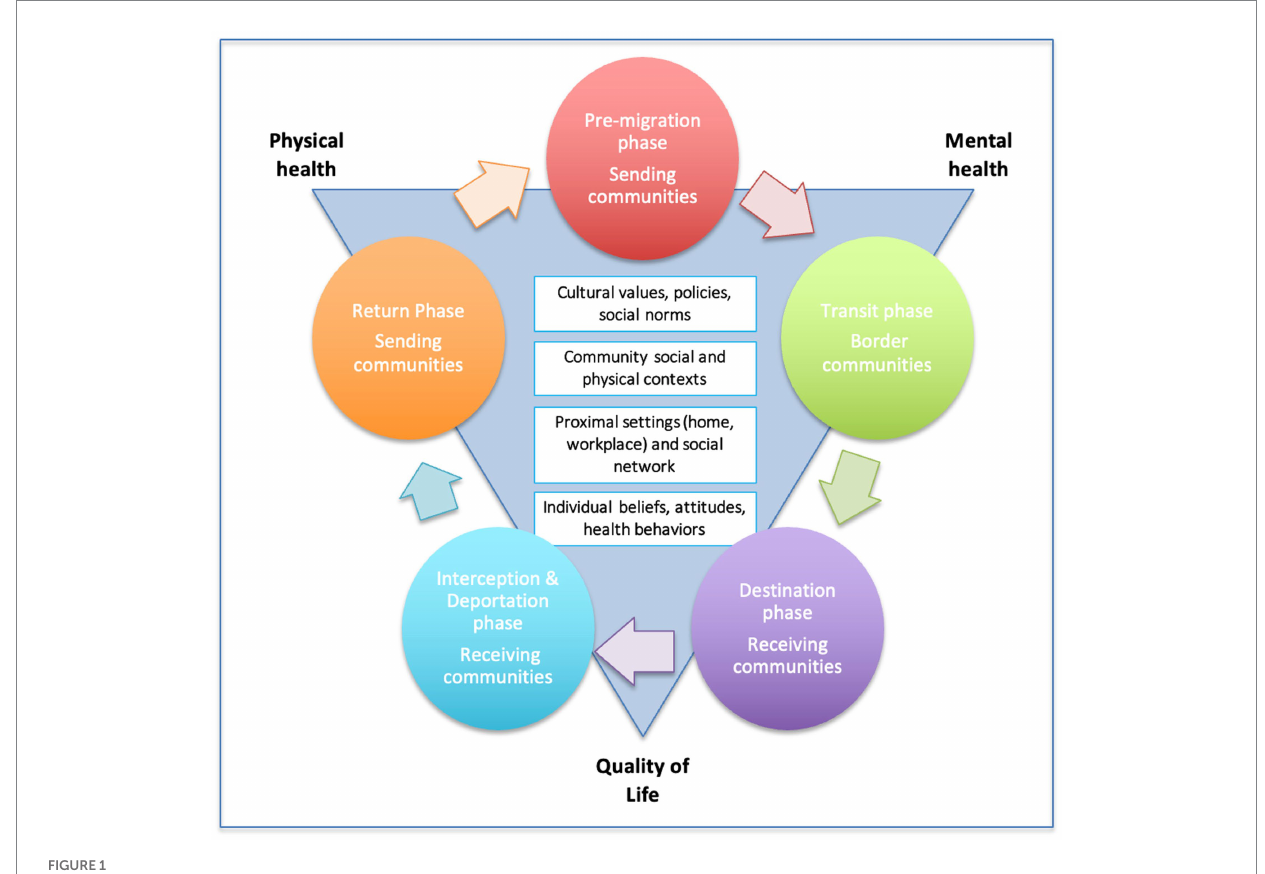
FIGURE 1 Theoretical framework of the Migrante